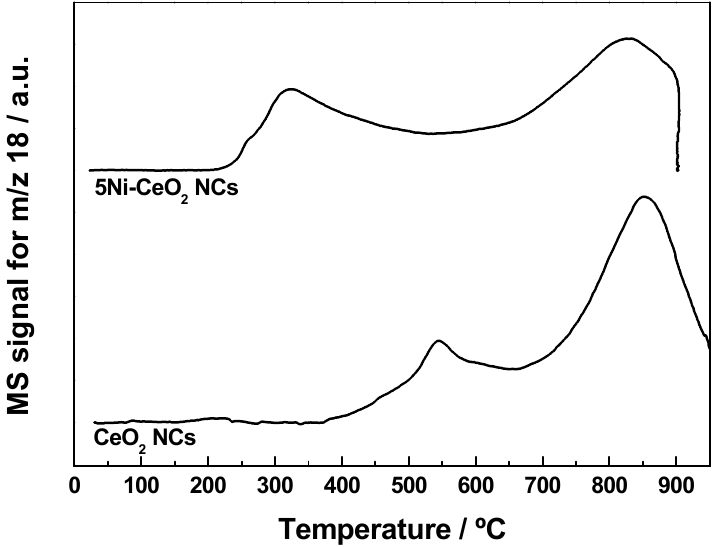
Figure 4. TPR-MS profiles for the CeO 2 NCs and 5Ni-CeO 2 NCs samples.